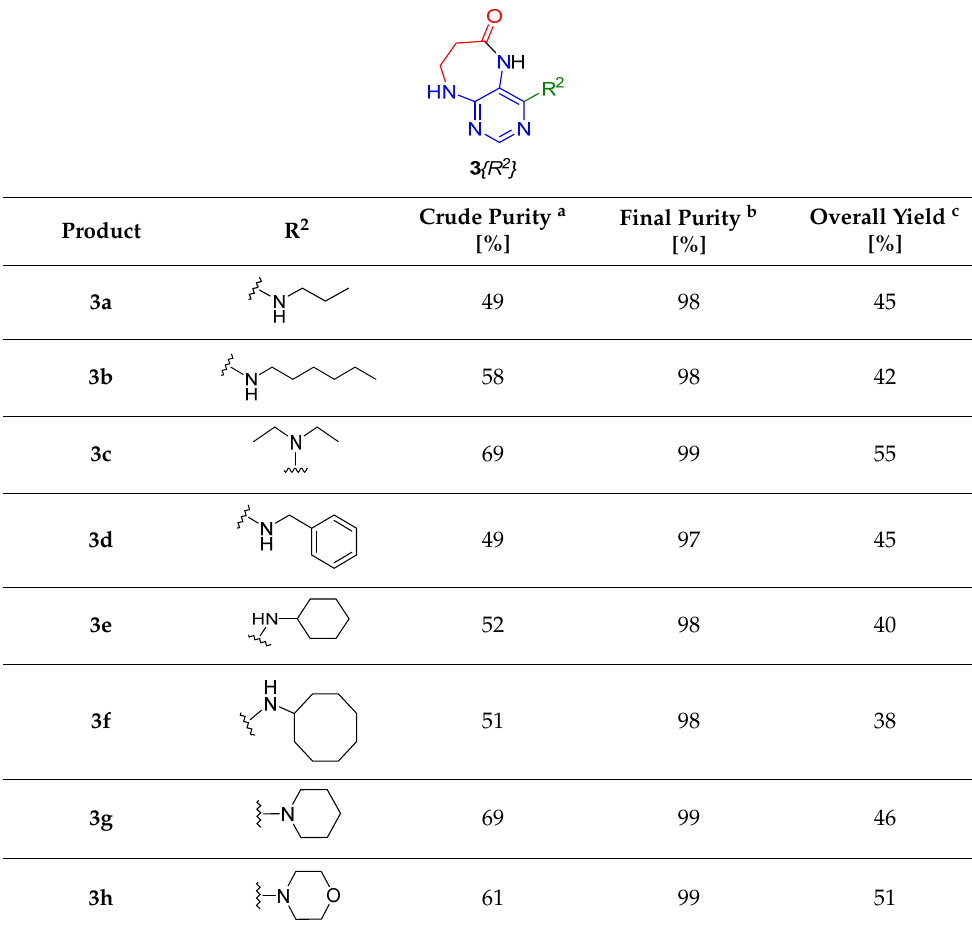
Table 4. Overview of synthesized pyrimidodiazepinones 3 .